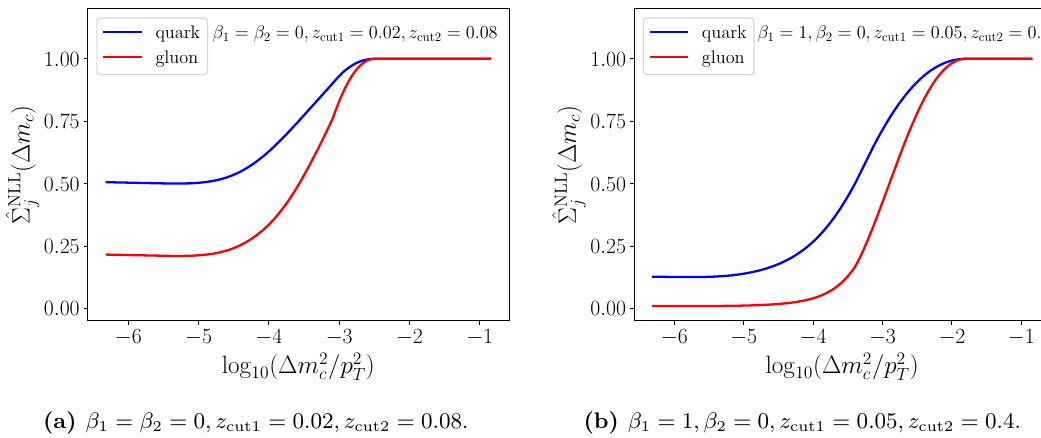
Figure 2. Perturbative results of the cumulative jet mass in collinear drop for quark and gluon jets. The constant feature in the limit ∆ m 2 → 0 depends on both the jet content and the collinear c drop